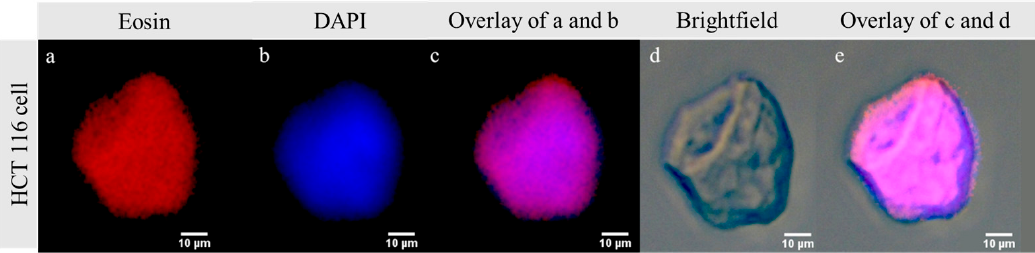
Figure 3. Fluorescence microscopy images of human colon cancer cell (HCT116) captured using MNG@Tf at 400 × magnification. ( a ) Captured HCT 116 image under Eosin filter; ( b ) captured HCT 116 image under DAPI filter; ( c ) merged image of Eosin and DAPI filters; ( d ) bright-field image of captured HCT 116; ( e ) multichannel image of HCT 116 ( c , d ).